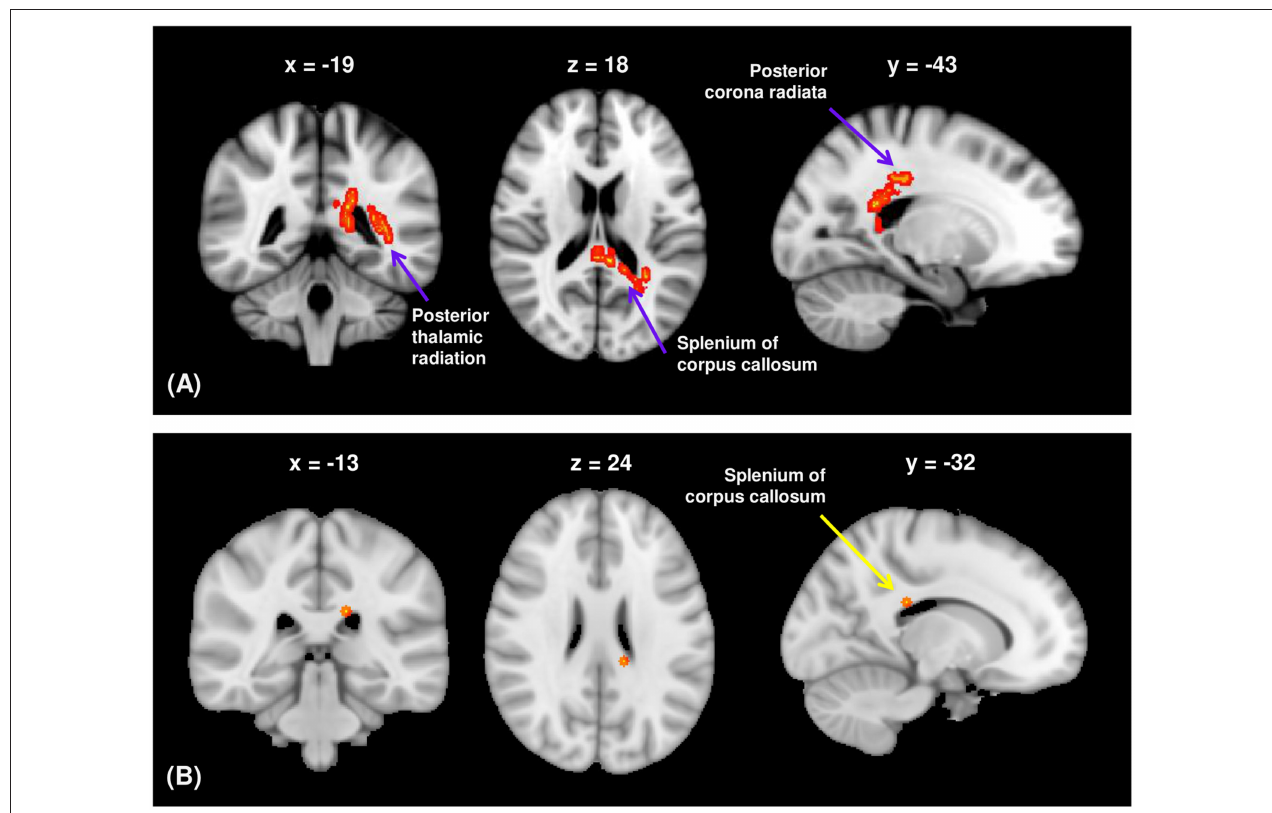
FIGURE 2 | (A) The FA of the white matter regions showed significant positive correlations with the aggressive and agitated behavior scores from the SAPS in participants with schizophrenia (TFCE-corrected p < 0.05). (B) The RD of the splenium of corpus callosum showed significant negative correlations with the aggressive and agitated behavior scores from the SAPS in participants with schizophrenia (TFCE-corrected p < 0.05). FA, fractional anisotropy; RD, radial diffusivity; SAPS, Scale for Assessment of Positive Symptoms; TFCE, threshold-free cluster